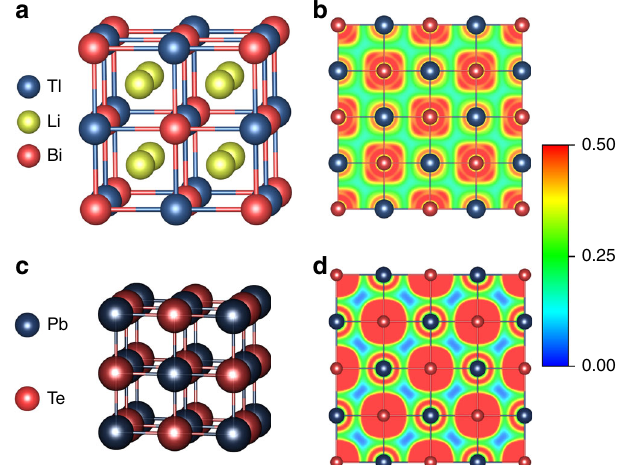
Fig. 1 Crystal and electronic structures. a Crystal structure of full Heusler Li 2 TlBi. b Electron localization function (ELF) of Li 2 TlBi in (001) plane. c Crystal structure of PbTe. d ELF of PbTe in (001)